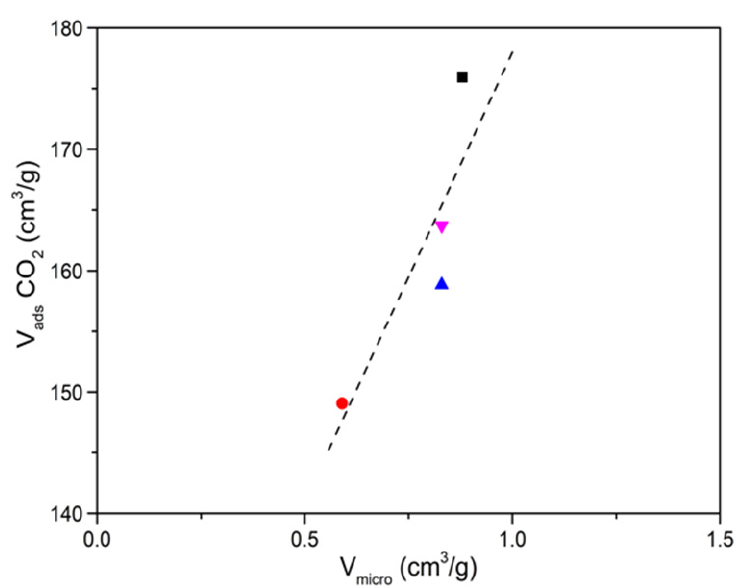
Figure A11. Schematic drawing of different groups of N in a graphene sheet.